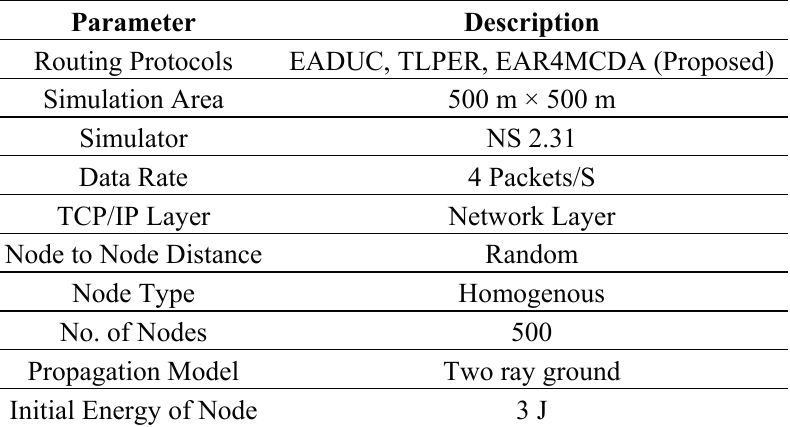
Figure 6. Total energy consumption in cluster design. Table 3. Simulation